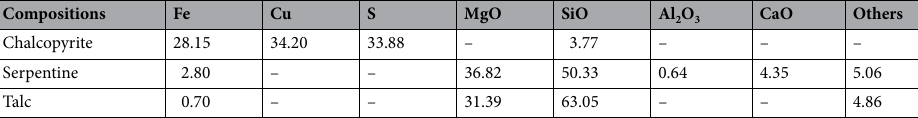
Table 1. Chemical compositions of chalcopyrite, serpentine and talc (mass fraction, %) by XRF analysis.